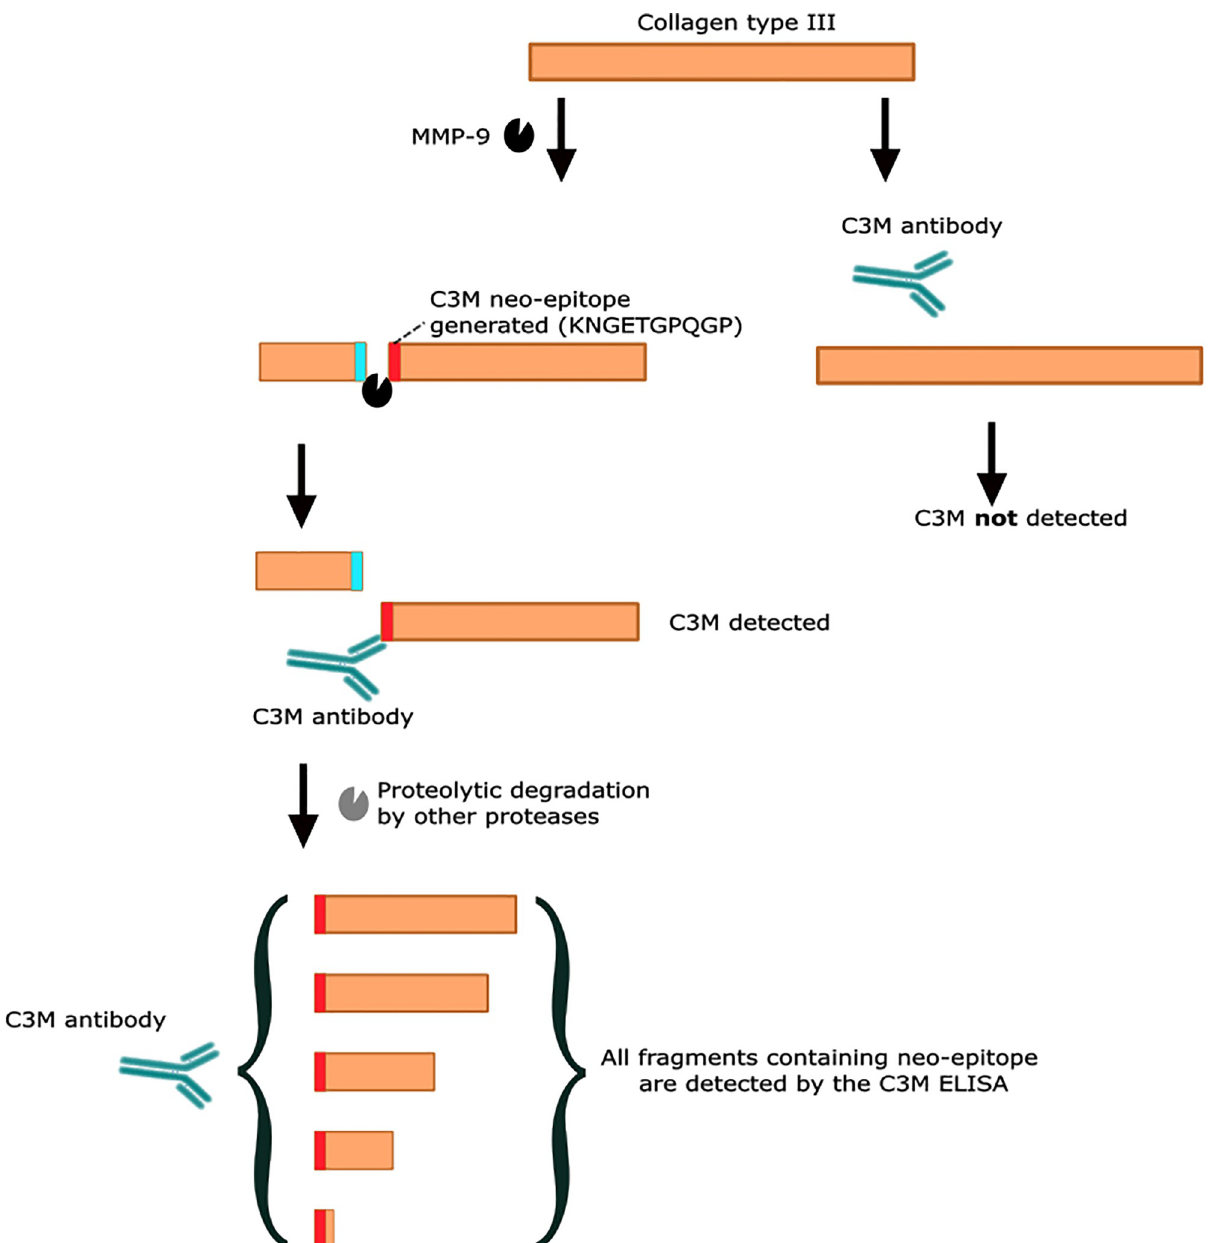
Fig 1. Generation and detection of C3M fragments. C3M is generated by degradation of collagen type III by the matrix metalloproteinase (MMP)-9, which produces a 10 amino acid neo-epitope (KNGETGPQGP). The ELISA antibody detects this neo-epitope and can thereby detect fragments of down to 10 amino acids. ELISA: enzyme-linked immunosorbent